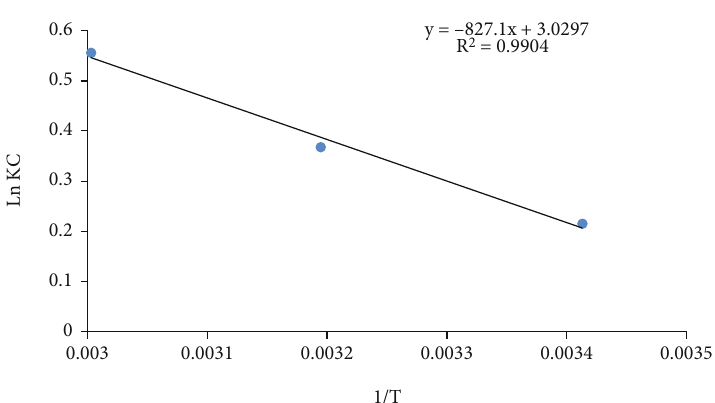
Figure 11: E ff ect of temperature on adsorption of safranin on GA/AM (adsorbent 0.01, dye solution 10mL, time 60 min, pH11, temp 293, 313, 333 K).